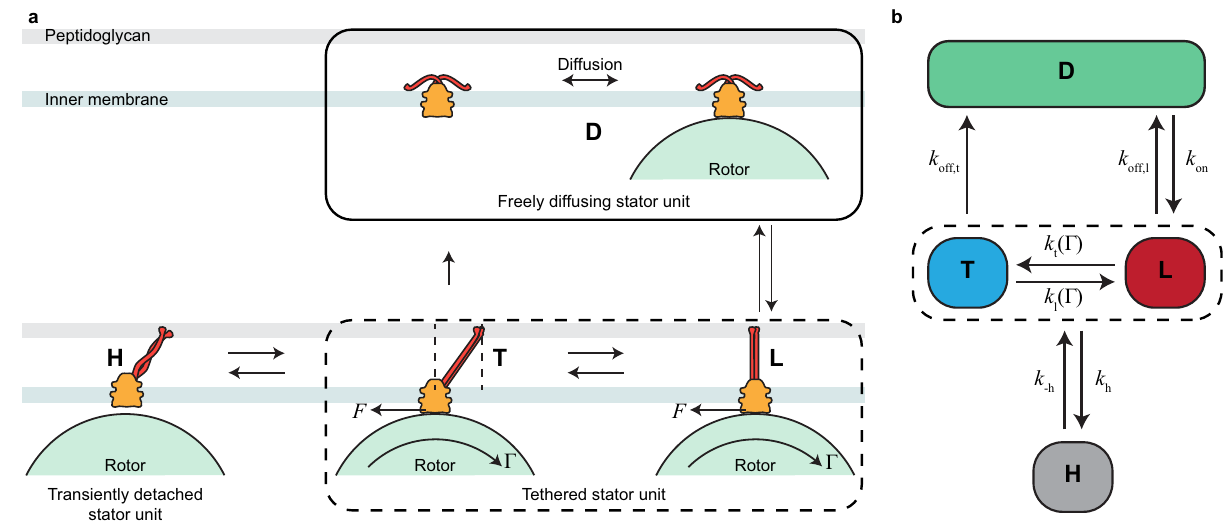
Fig.2|Amulti-statemodelforadaptivestatorremodeling.a Anunboundstator unitisinaclosedstate(D)inwhichitfreelydiffuseswithintheinnermembraneand does not translocate protons. Upon interacting with a rotor of radius R , the stator unittransitionsintoalooselyboundstate(L).Inthisstate,theprotonsstart fl owing through the statorunit, resulting in the production of a torque Γ on the rotor. Asa reaction,aforce F = Γ / R actsonthestatorunit,whichdisplacesitinthedirectionof the force. This displacement away from the point of tether lowers the off rate and results in a tightly bound state (T). A bound stator unit can occasionally detach